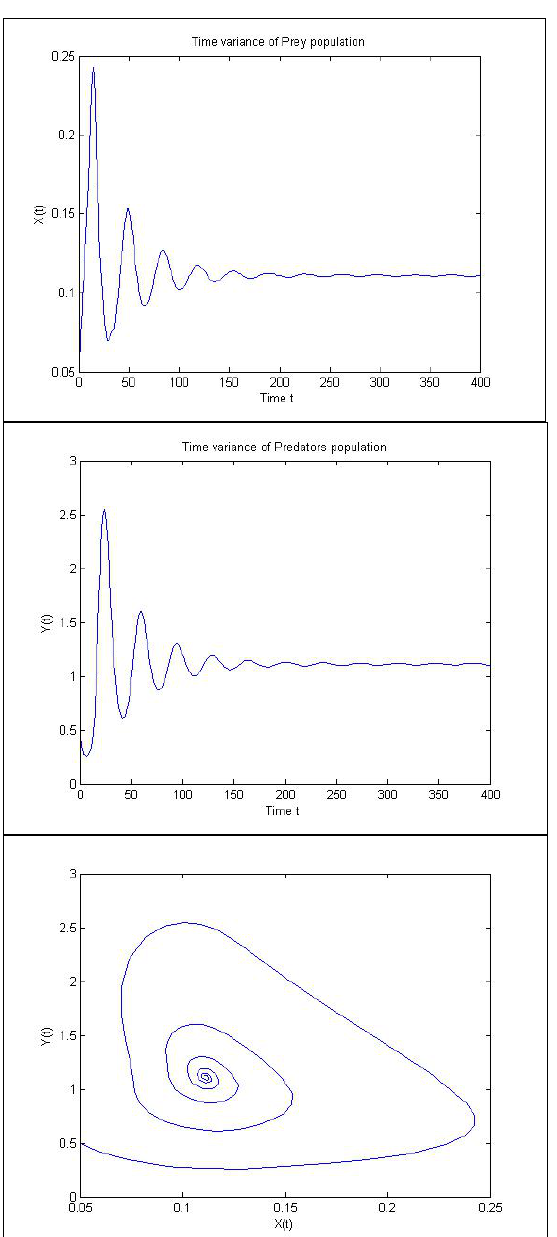
Fig. 10. The positive equilibrium is stable for τ 1 = 7 and τ 2 = 1 . 2 .The system exhibits a spiral in toward the equilibrium ( x ∗ 1 , y ∗ 1 ) = (0 . 111 , 1 . 111) .